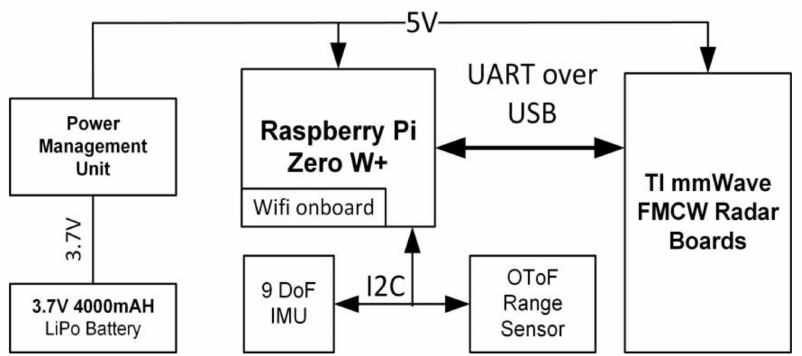
Figure 5. Hardware block diagram of smart-shoe prototype. The Raspberry Pi acts as the main command and control device, as well as a datalogger. The main sensor is the TI mm-wave radar, and the secondary sensors are a nine degree of freedom IMU and Optical Time-of-Flight range finder. A Raspberry Pi Zero W+ was selected as the control and data logging unit due to its reduced size and its Wi-Fi capability. Two additional sensors were included, an Inertia Measurement Unit with nine degrees of freedom (three accelerometers, three gyroscopes and three magnetometers) and an Optical Time-of-flight distance measurement